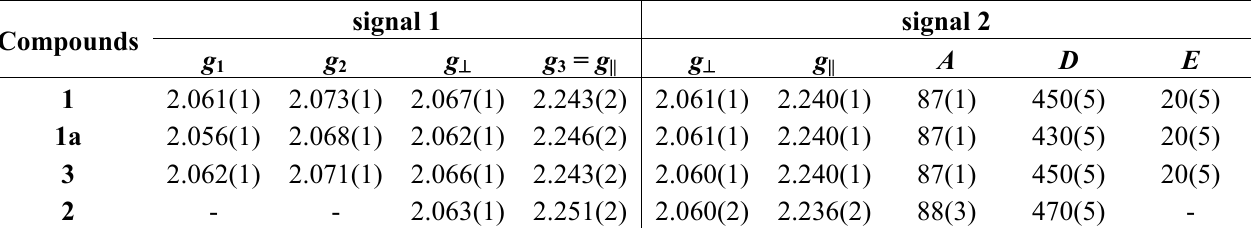
Table 3. Spin Hamiltonian parameters g , A , D and E (×10 − 4 cm − 1 ) for compounds 1 , 1a , 2 and 3 . signal 1 signal 2 Compounds g